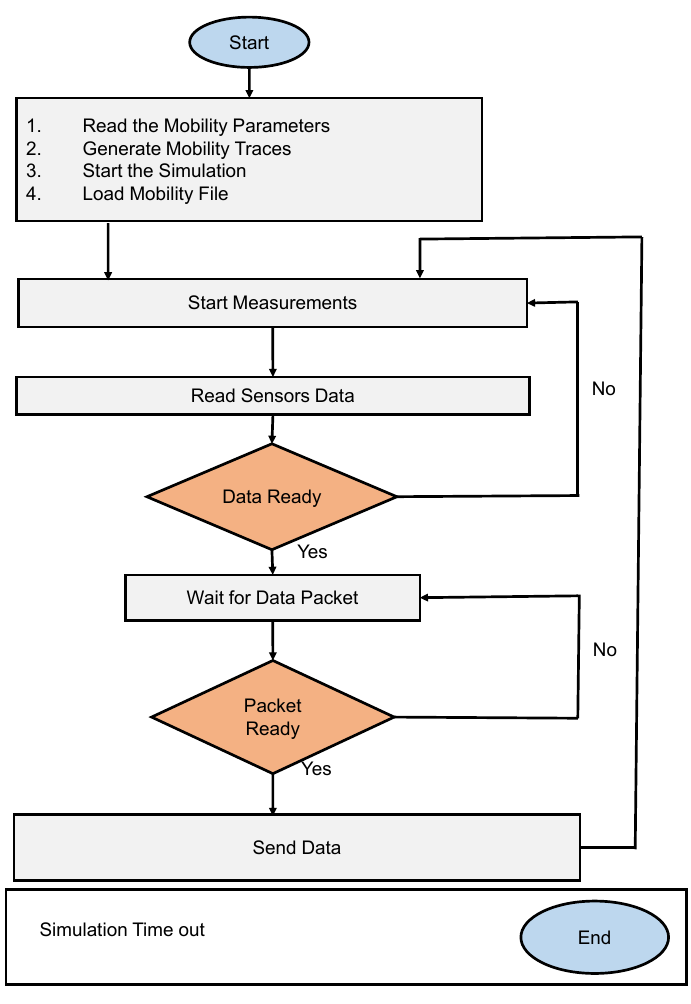
Figure 5. Simulation